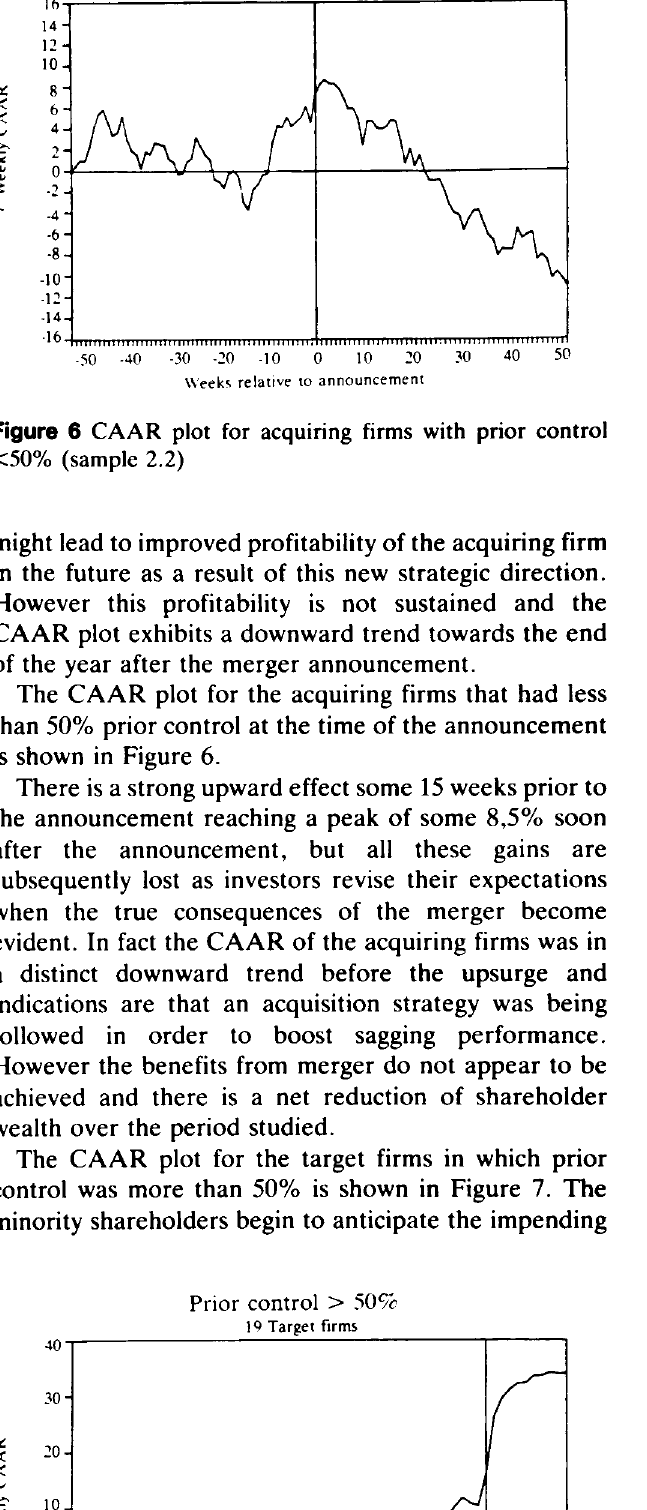
Figure 5 CAAR plot for acquiring firms with prior control >50% (sample 2.1)